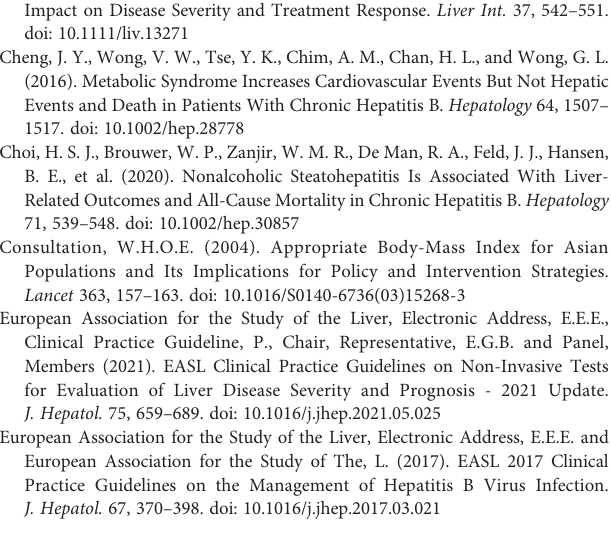
Supplementary Figure 1 | Patients recruitment. Patients with NASH was diagnosed as SAF Score; HCC: hepatocellular carcinoma; excessive alcohol consumption: de fi nedasalcohol intake ≥ 20gperdayformenand ≥ 10gperdayfor women; poor quality liver samples: de fi ned as liver sample less than 10mm in length or containing less than six portal triads. Supplementary Figure 2 | (A) FLIP algorithmic tree in lean population. A total of 512 patients with treatment naïve chronic hepatitis B with BMI ≤ 23 kg/m 2 were classi fi ed into no NAFLD, NAFL, NASH or severe NASH according to the FLIP algorithmic pathways based on the grade of steatosis (Panel a, light yellow shade), grade of Ballooning (Panel a, light blue shade) and grade of lobular in fl ammation (Panel a, pink shade). Number of patients and the proportion among each category were presented as number (%). (B) Pie chart to illustrate the proportion of lean patients (BMI ≤ 23 kg/m2) with speci fi c diagnosis. Among all 512 patients, 76.2% had no NAFLD and the remaining 23.8% had NAFLD, among which, 85.3% had NAFL and 14.8% had NASH. FLIP, fatty liver inhibition of progression; NAFLD, non- alcoholic fatty liver disease; NAFL, non-alcoholic fatty liver; NASH, non-alcoholic steatosis hepatitis. Supplementary Figure 3 | (A) Bar chart to illustrate the proportion of fi brosis stage in HBV-infected patients with or without steatosis. 53.6% had signi fi cant fi brosis (S ≥ 2) among patients without steatosis and 47.3% had signi fi cant fi brosis (S ≥ 2) among patients with steatosis. (B) Bar chart to illustrate the proportion of fi brosis stage in HBV-infected patients with or without lobular in fl ammation. 27.9% had signi fi cant fi brosis (S ≥ 2) among patients without lobular in fl ammation and 52.7% had signi fi cant fi brosis (S ≥ 2) among patients with lobular in fl ammation. (C) Bar chart to illustrate the proportion of fi brosis stage in HBV-infected patients with or without cytological ballooning. 41.5% had signi fi cant fi brosis (S ≥ 2) among patients without cytological ballooning and 68.9% had signi fi cant fi brosis (S ≥ 2) among patients with cytological